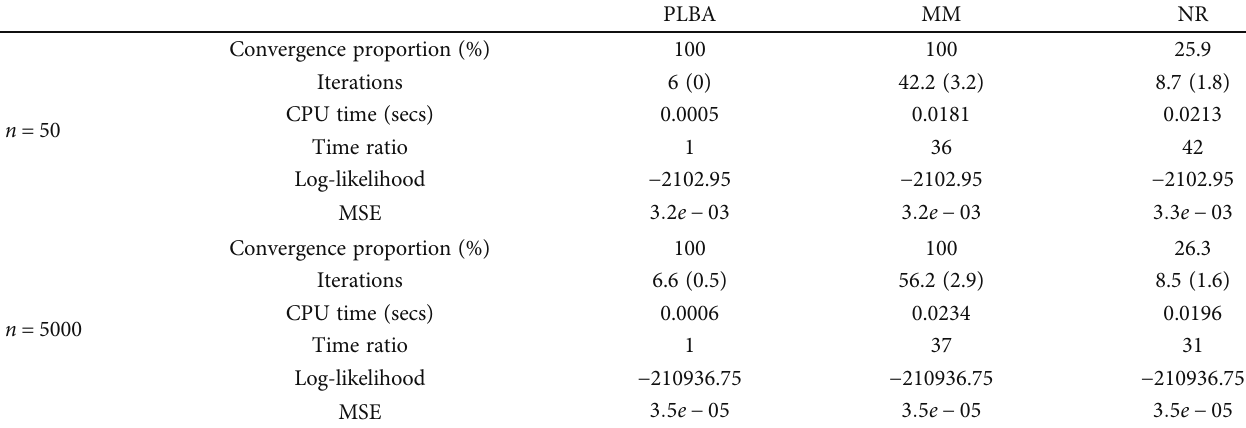
Table 6: Results for Scenario 5 (Values in brackets are standard deviations).